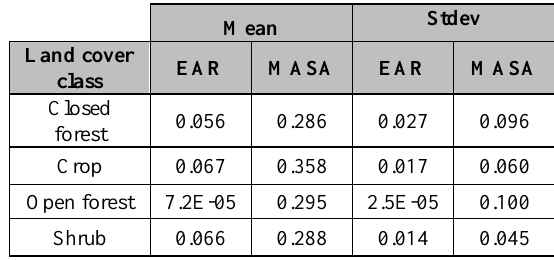
Table 3. Mean and standard deviation values in a cover class per EAR and MASA